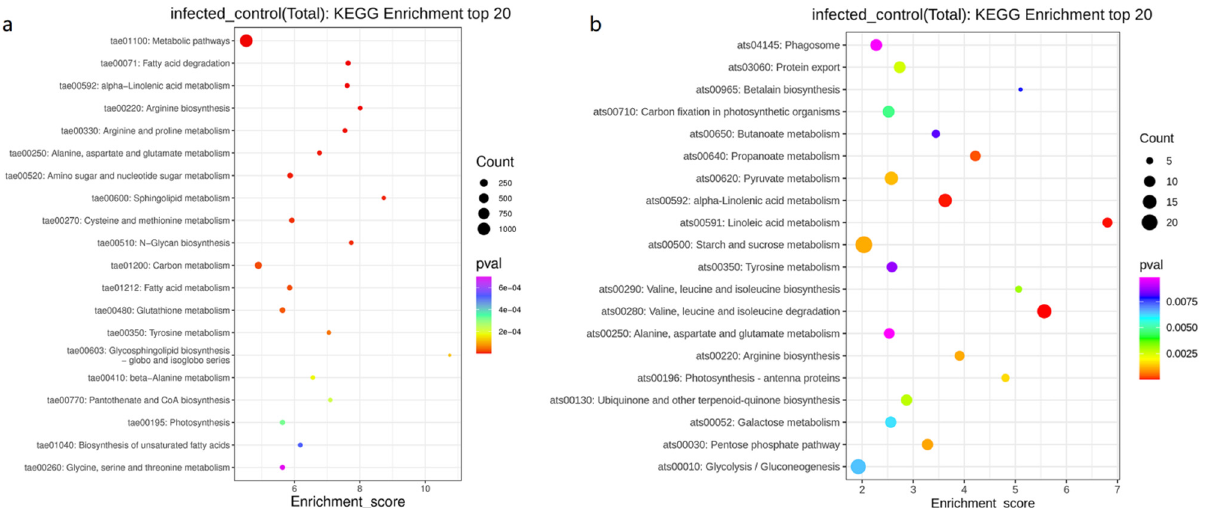
Figure 4. KEGG enrichment analysis scatter plot representing pathways of differentially expressed proteins. ( a ) Differentially expressed proteins of T. controversa -infected libraries. ( b ) Differentially expressed proteins of T. foetida -infected libraries.